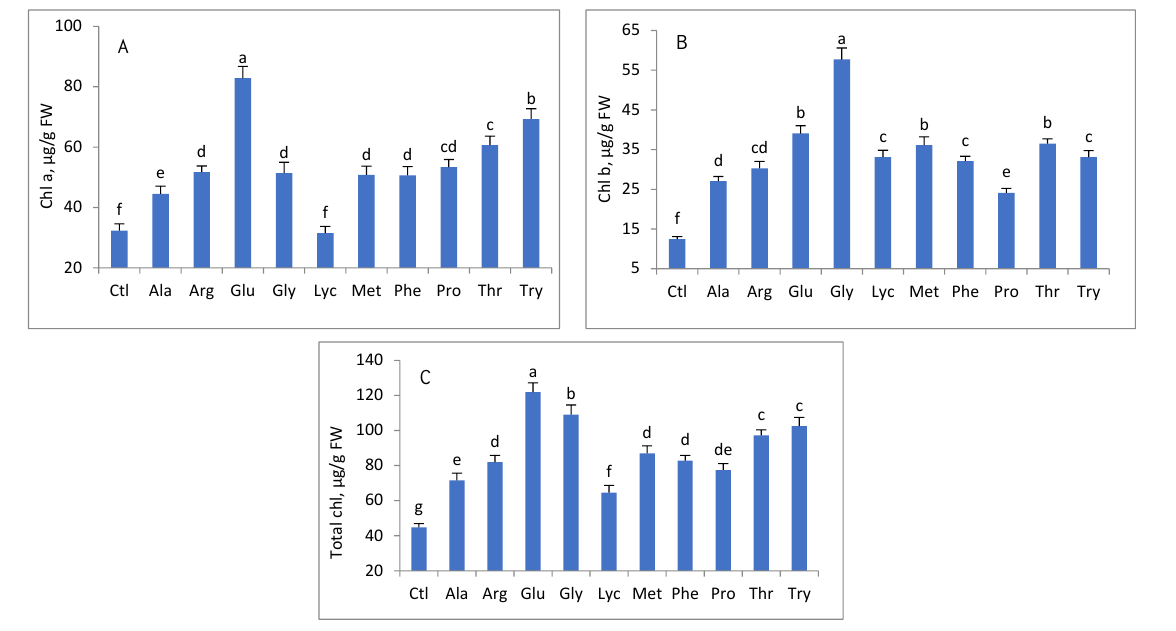
Figure 6. Effect of priming onion seeds with exogenous amino acids. ( A ) —chlorophyll content, μg/g FW; ( B ) —chlorophyll b, μg/g FW; ( C ) —total chlorophyll, μg/g FW. Ctl (Control); Ala (Alanine); Arg (Arginine); Glu (Glutamine); Gly (Glycine); Lys (Lysine); Met (Methionine); Phy (Phenylalanine); Pro (Proline); Thr (threonine); Try (tryptophan). Columns that share the same letter(s) are not statistically significant at p ≤ 0.01.